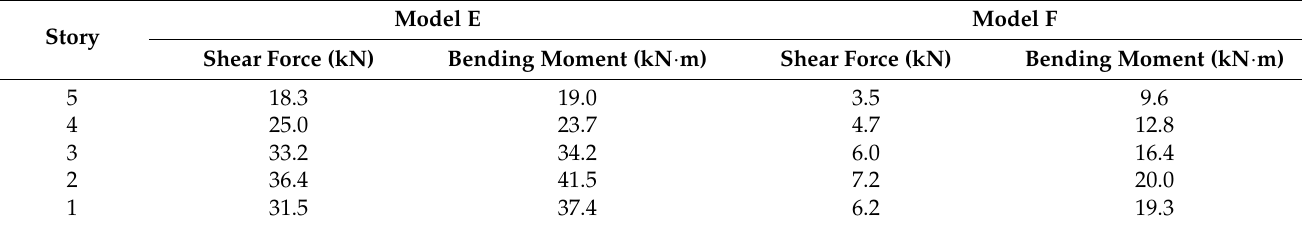
Table 7. A comparison of the internal force of stair beams.